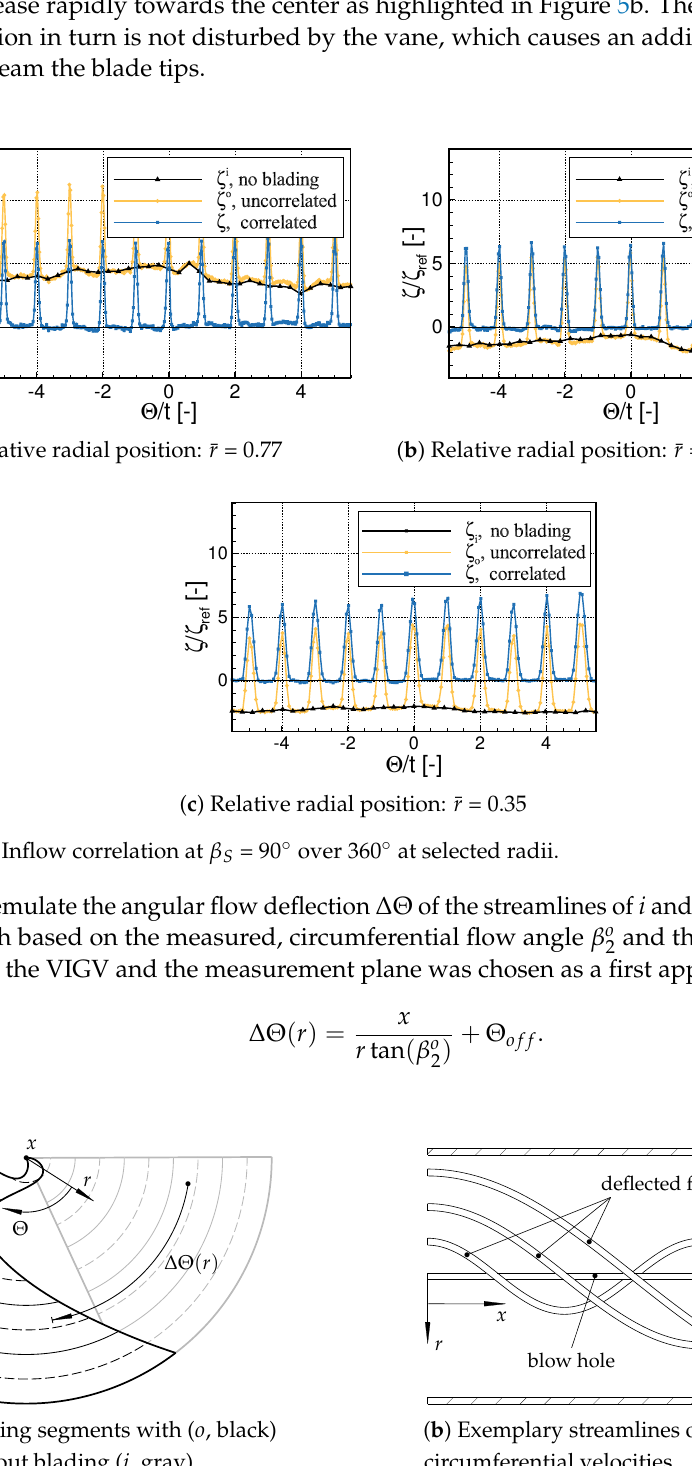
Figure 5. Stretching of the flow field at β S